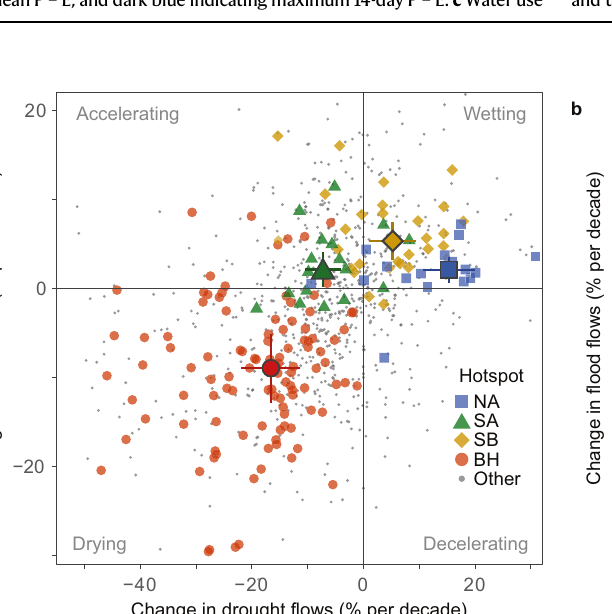
Fig. 2 |Stream fl owtrendsandcontributing driversin fourhotspotsofchange. a Stream fl ow trends, with light grey boxes indicating minimum 7-day fl ows (drought fl ows), medium grey indicating mean fl ows, and dark grey indicating maximum daily fl ows ( fl ood fl ows). b Climatic trends, with light blue boxes indi- cating minimum 90-day precipitation minus evaporation (P – E), medium blue indicating meanP – E,and dark blue indicating maximum 14-dayP – E. c Wateruse